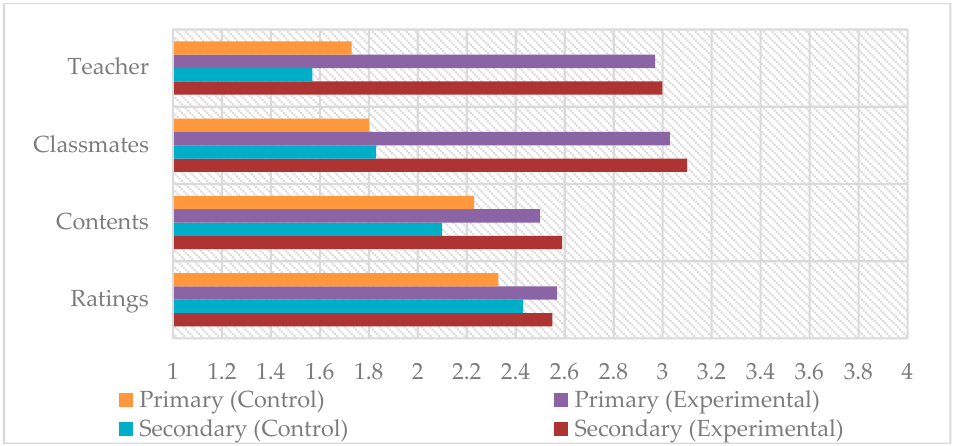
Figure 1. Intergroup comparison in attitudinal dimension.